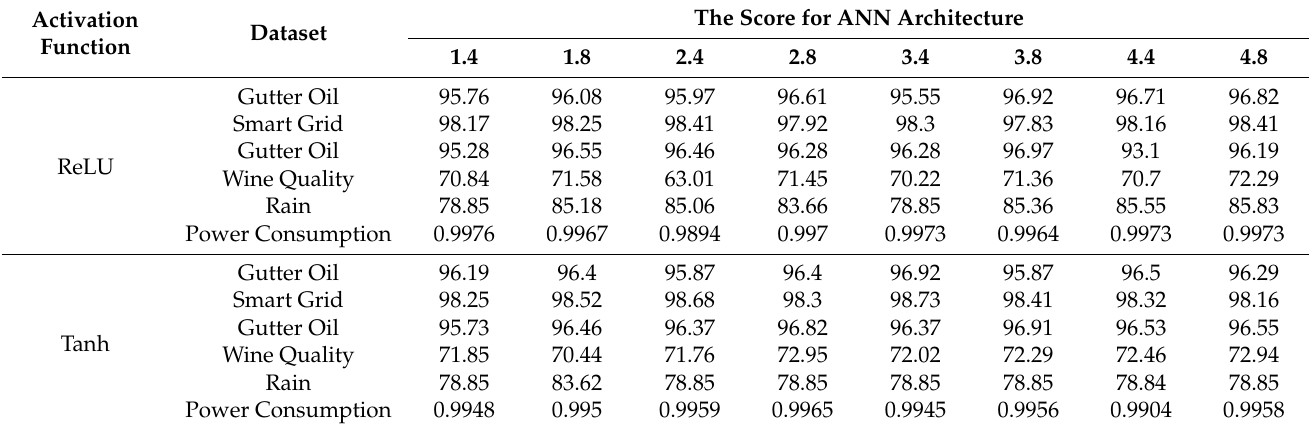
Table A1. The score for different ANN architectures and activation